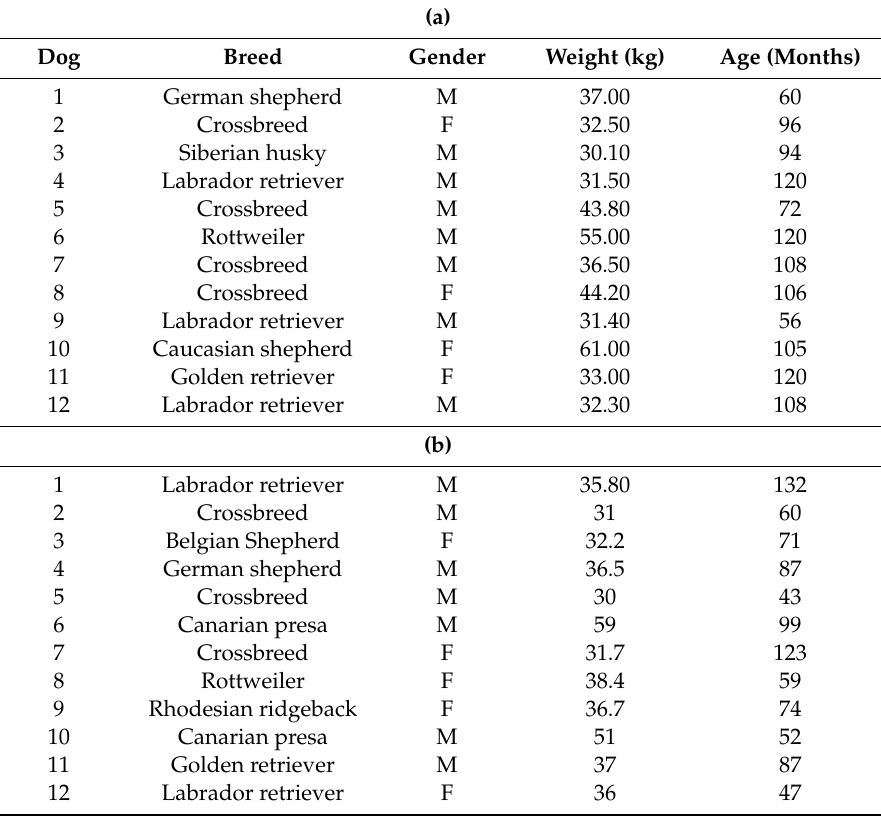
Table 1. ( a ). Descriptive data of each patient included in the group PRGF. ( b ) Descriptive data of each patient included in the group PRGF +